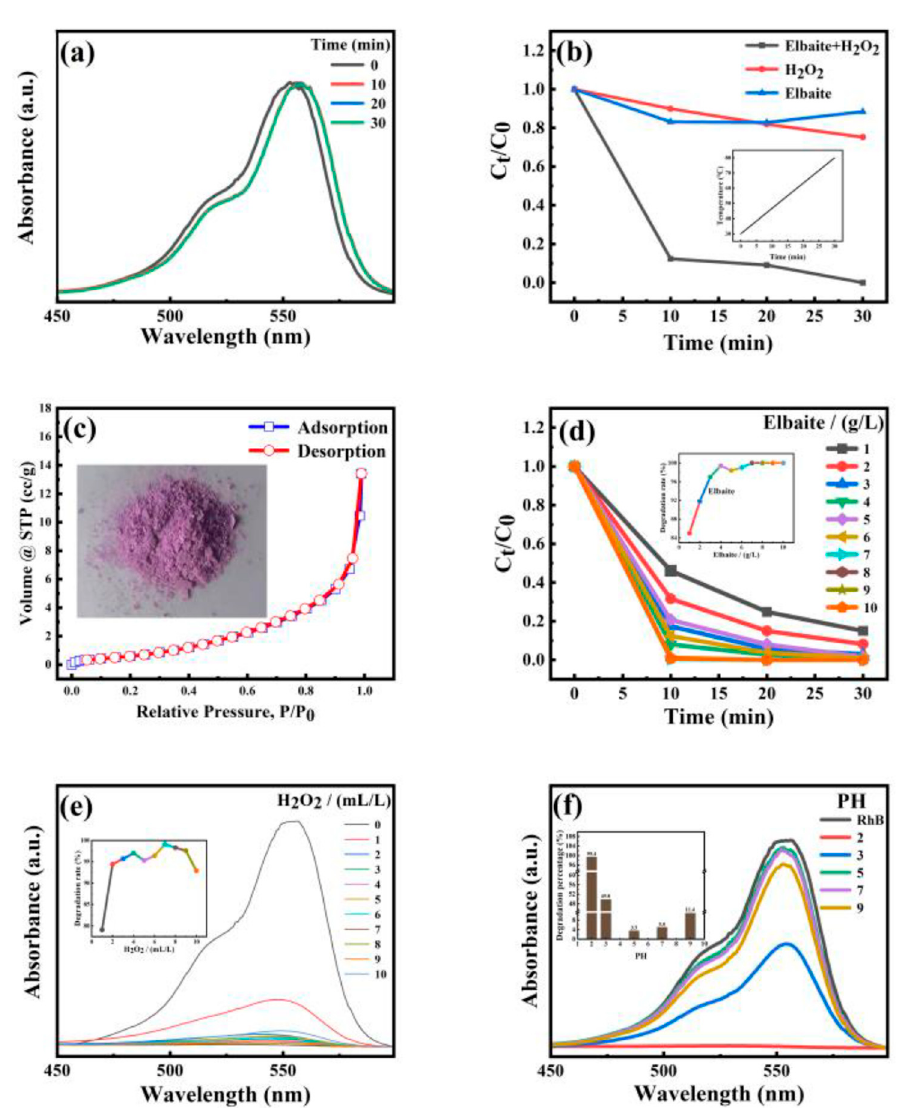
Figure 2. ( a ) Pyrocatalytic UV absorption spectrum of RhB without catalyst. ( b ) RhB removal rates in three different systems. ( c ) N2 adsorption–desorption isotherm of elbaite powder and the picture of elbaite powder after adsorption reaction. ( d ) Effect of elbaite dose on RhB degradation in the elbaite/H2O2 system, and the degradation rate of different elbaite doses. ( e ) Effect of H2O2 dose on RhB degradation in the elbaite/H2O2 system, and the degradation rate of different H2O2 doses. ( f ) Effect of initial pH on the degradation of RhB in the elbaite/H2O2 system, and the degradation rate at different pH. Experimental conditions: RhB = 100 mg/L, elbaite dose = 1.0–10.0 g/L, H2O2 dose = 1.0–10.0 mL/L, initial pH = 2.0, 3.0, 5.0, 7.0, 9.0, T = 30 °C–80 °C, time = 30 min.